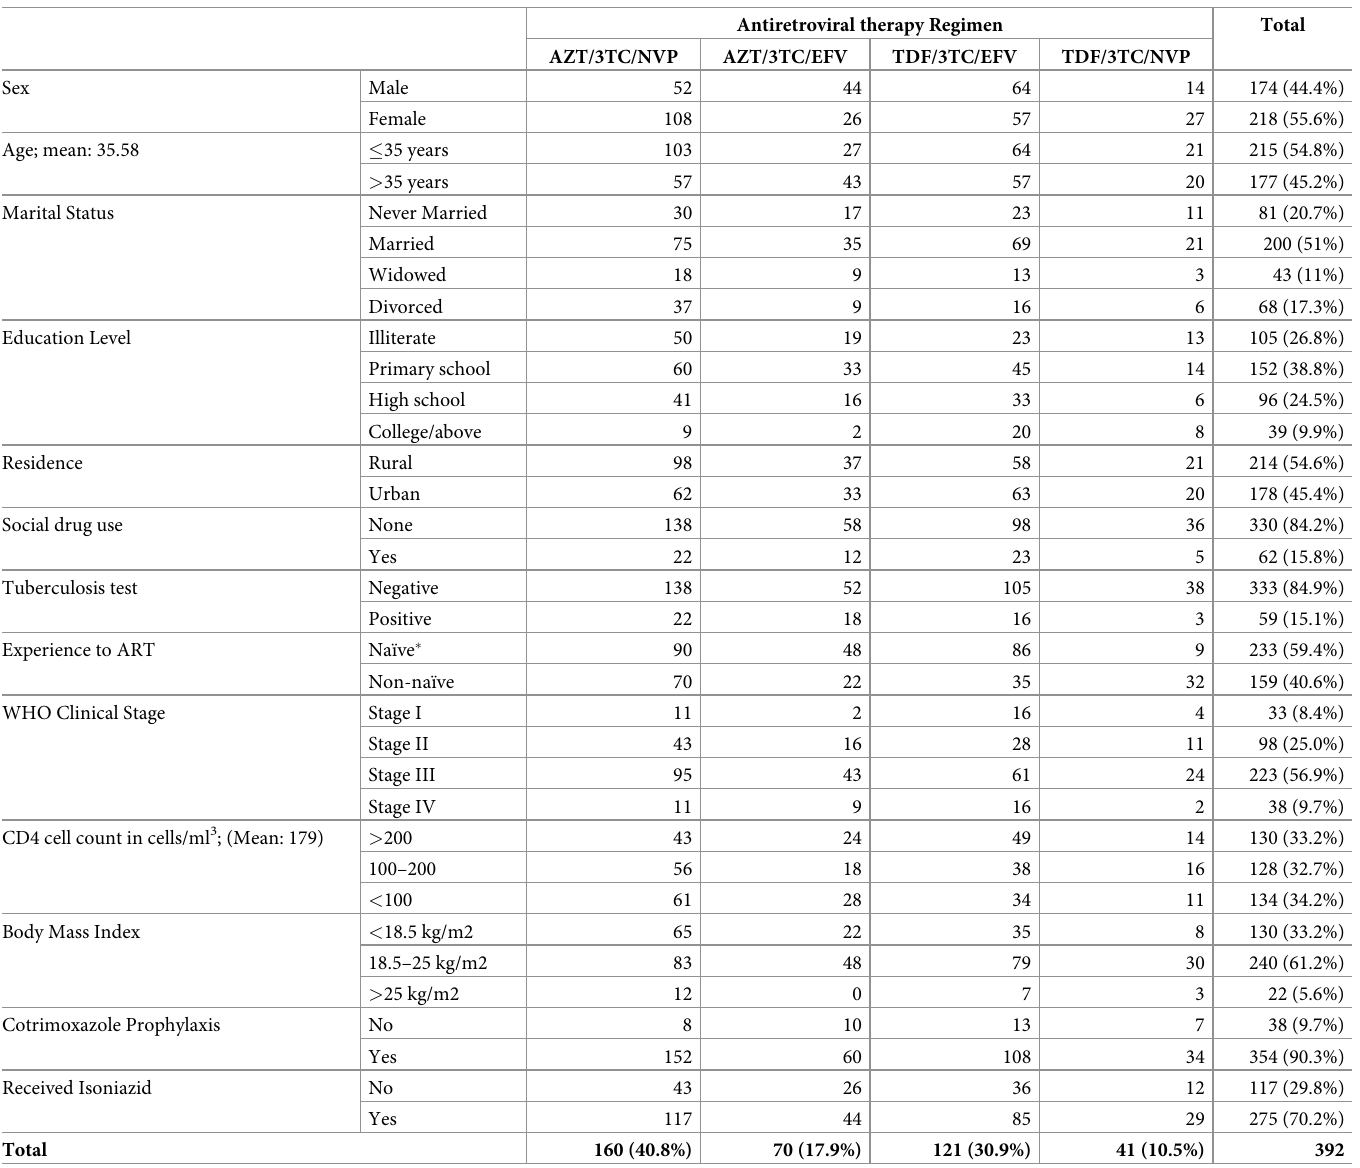
Table 1. Baseline characteristics of patients on HAART in Northeast Ethiopia: